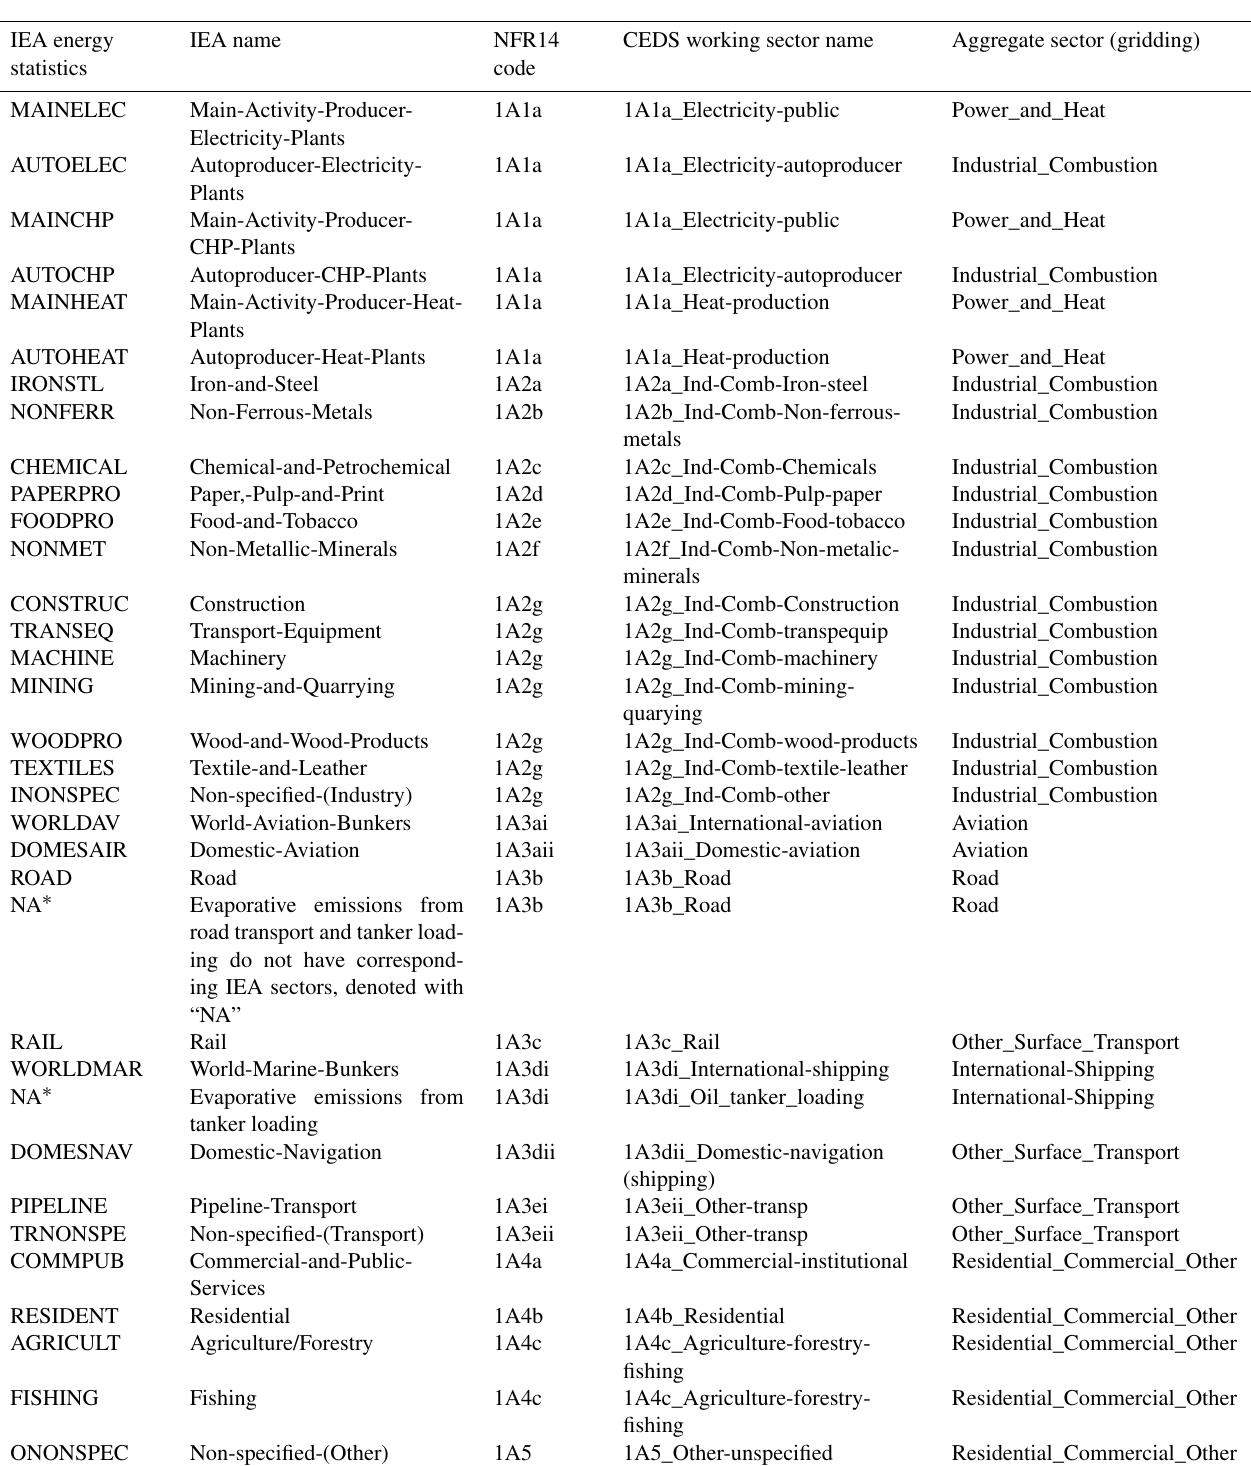
Table A1. Sector definitions of combustion emissions (IEA and NFR14